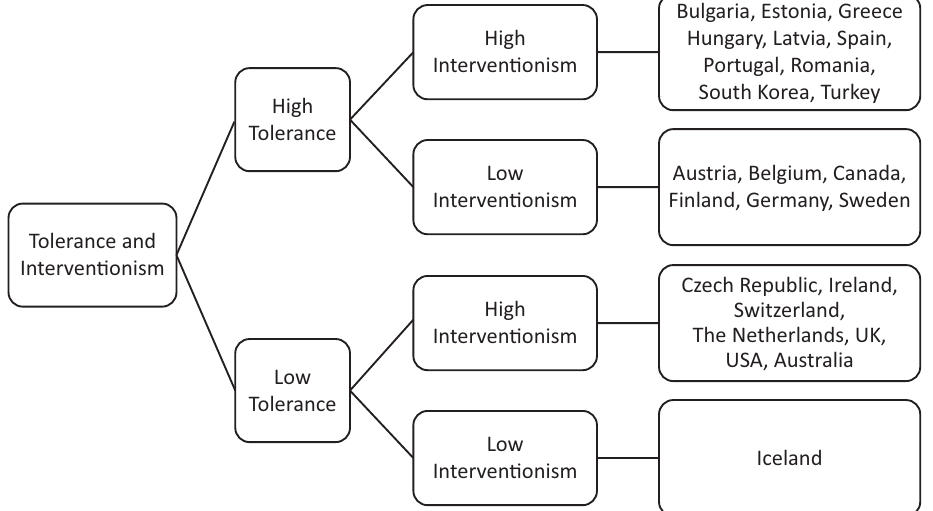
Figure 6. Four clusters of the press based on interventionism and journalists’ perception of their role as promoting toler- ance and cultural